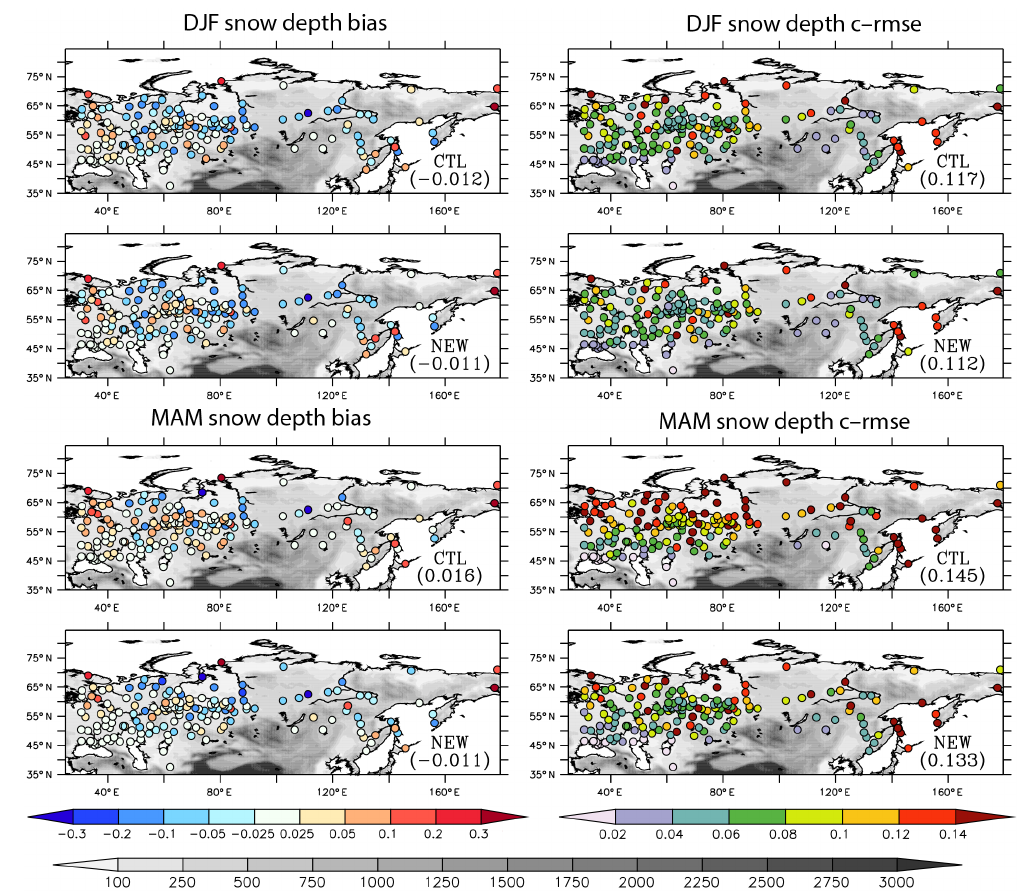
Figure 9. Daily snow depth skill scores (bias and c-rmse) simulated by the CTL and the NEW experiments during winter (DJF) and spring (MAM) over northern Eurasia and expressed in meters. Total scores given in parentheses are computed by merging together all simulated or observed daily time series of all stations for each